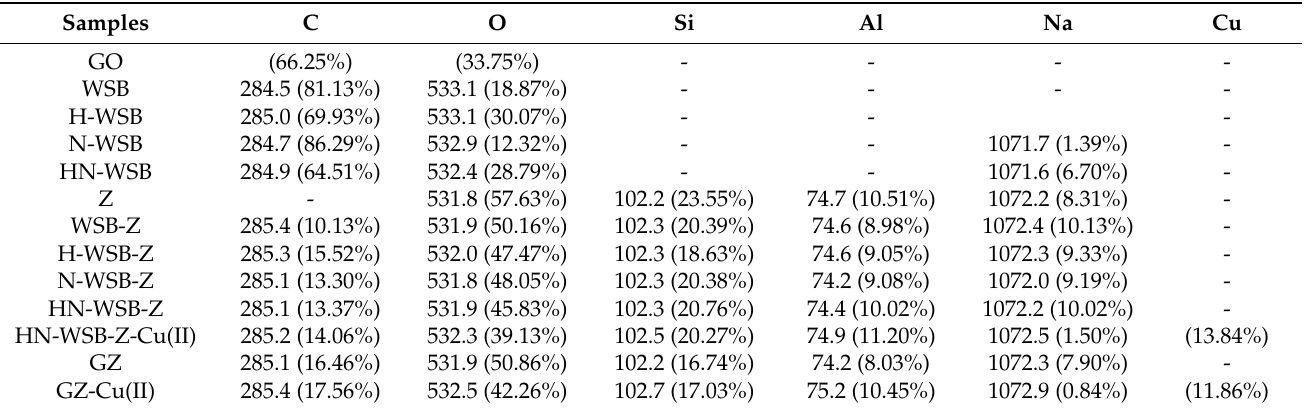
Table 2. The binding energy (eV) and relative content (wt.%) of elements of different carbon materials and zeolites via